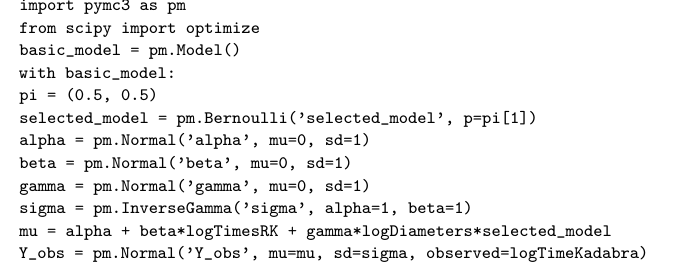
Figure 9. Listing to compute the Bayes factor, the relative likelihood of two models, between the model including the graph diameter and the model with just the graph sizes. The variable selected_model is an indicator for which model is